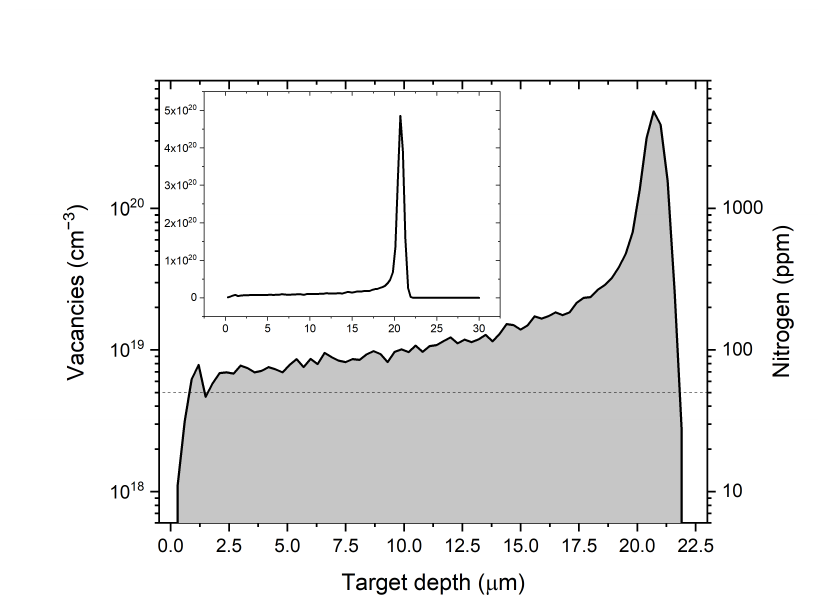
Figure 2. The graph shows the number of vacancies produced by proton irradiation with a dose 1.5 × 10 16 cm − 2 depending on the depth in the sample. It can be seen that the largest number of vacancies is generated at a depth of 20 µ m. The dashed line indicates the amount of nitrogen in the tested samples. The inset shows the same plot but with a linear scale.